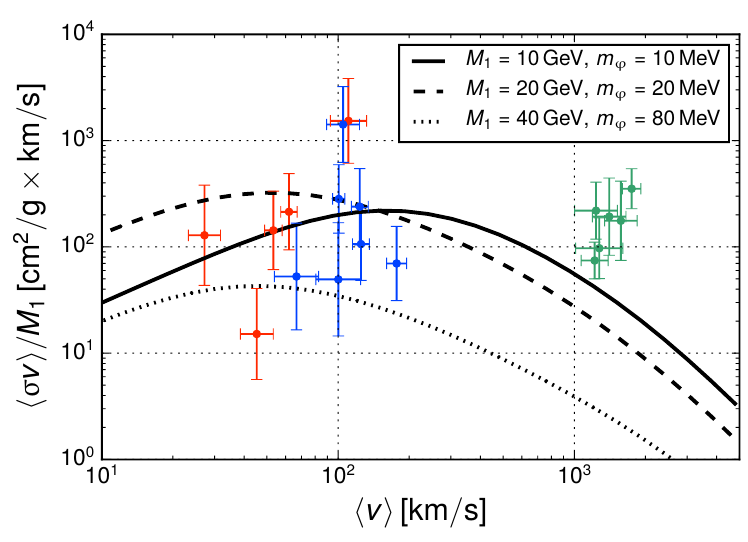
Figure 3 . Self-interaction cross sections, (cid:27) T v =M 1 , at the benchmark points taken from the left h i panel of (cid:12)gure 2. We take ( M 1 ; m ’ ) = (10 GeV ; 10 MeV) (solid), (20 GeV ; 20 MeV) (dashed) and (40 GeV ; 80 MeV) (dotted). The points with errors are taken from ref. [8], corresponding to dwarf galaxies (red), low surface brightness galaxies (blue), and galaxy clusters (green).